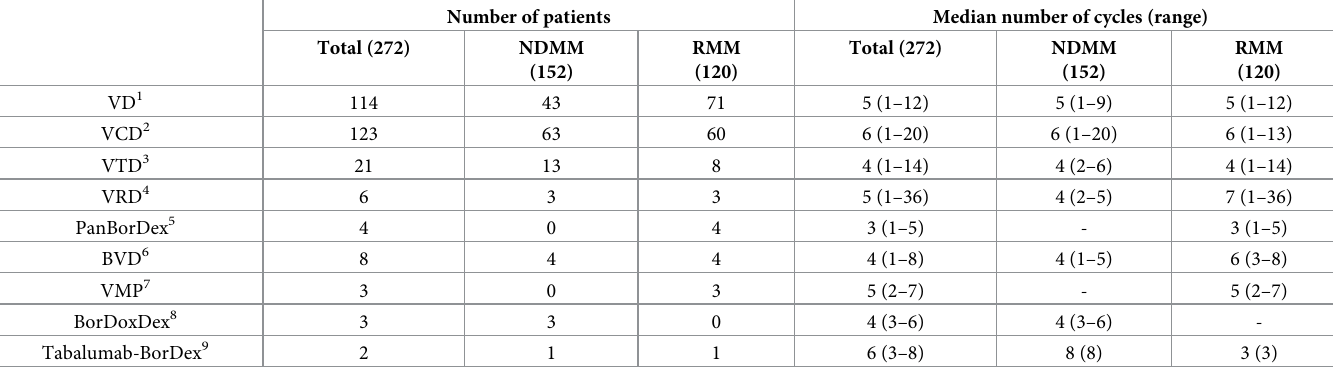
Table 2. Regimens used and median number of